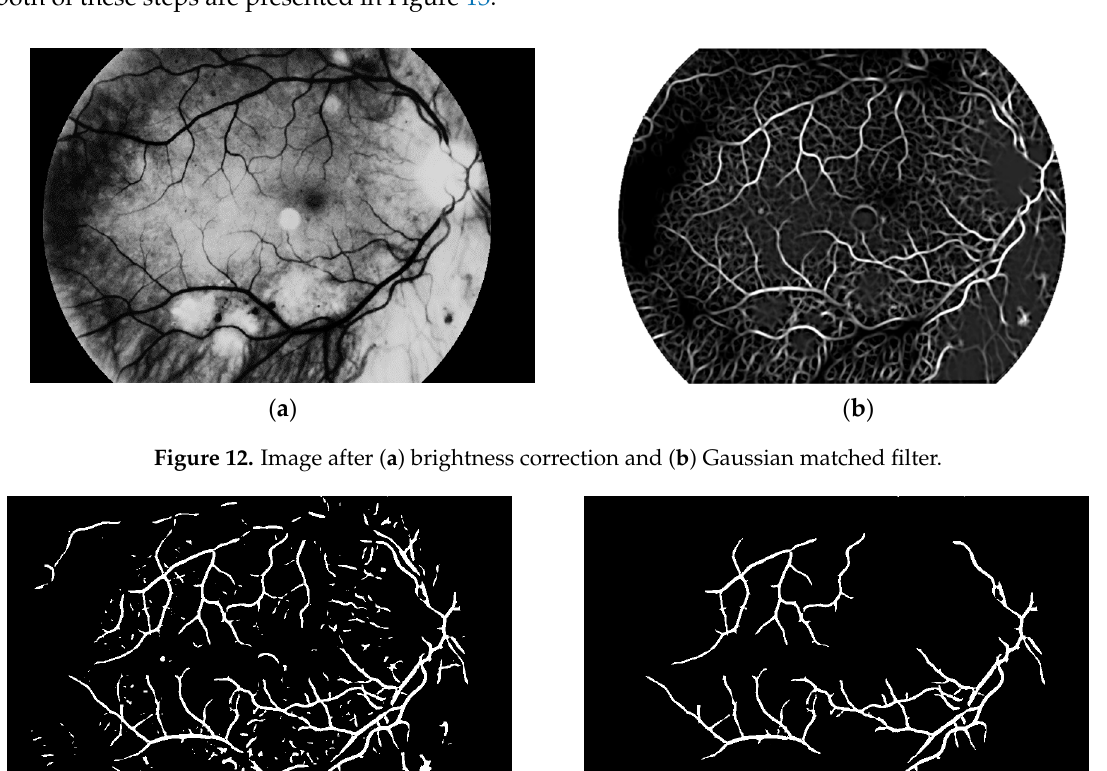
Figure 11. Image after ( a ) histogram equalization and ( b ) after brightness correction.